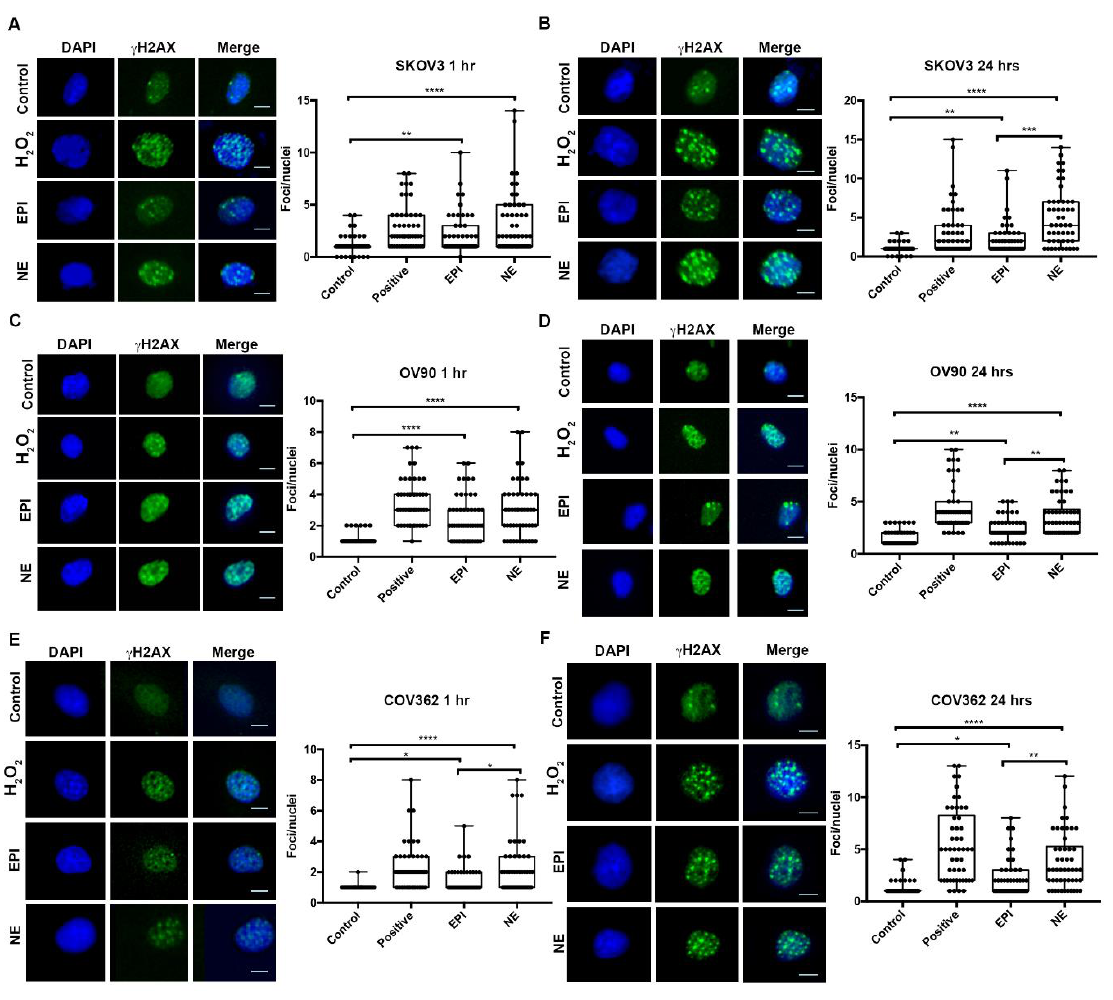
Figure 1. γ -H2AX foci formation after NE or EPI treatment in EOC cells. SKOV3 ( A , B ), OV90 ( C , D ), and COV362 ( E , F ) were treated with NE or EPI (10 µ M), left untreated (control), or treated with 30% H 2 O 2 (positive control) for 1 h or 24 h. After catecholamine exposure, cells were fixed and immune stained for γ -H2AX, and foci formation was assessed for fifty (50) cells per treatment. Statistical significance was determined by ANOVA with Dunn’s multiple comparison correction. (* p < 0.05, ** p < 0.01, *** p < 0.001, **** p < 0.0001). Scale bar = 10 µ M. Images are representative of three independent experiments.